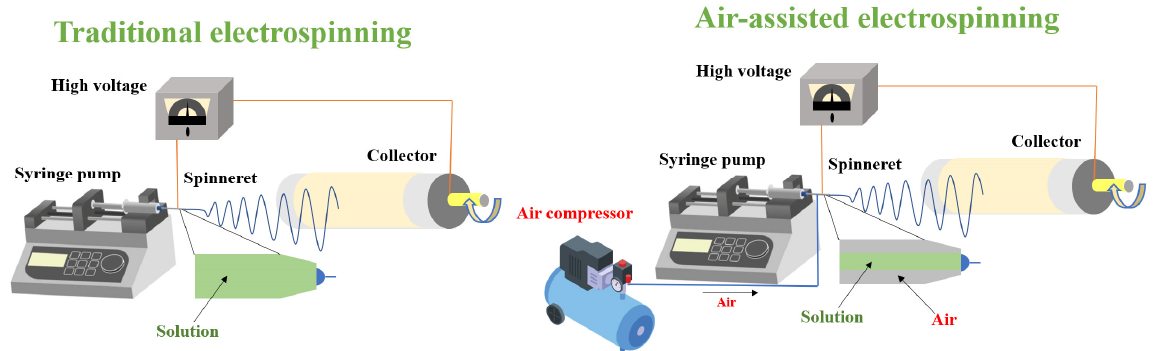
Figure 1. Schematic showing the traditional and air-assisted electrospinning setups .